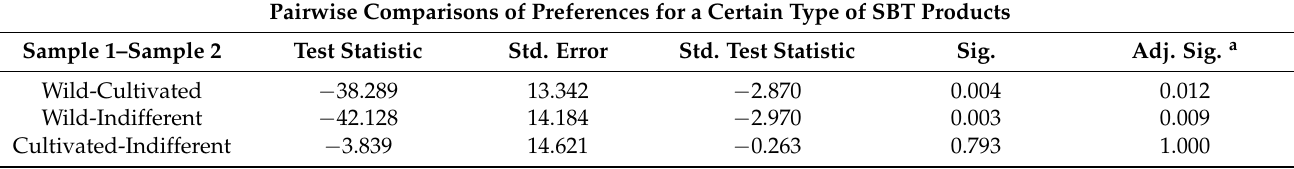
Table 5. Results of Kruskal Wallis test with the post-hoc test and Bonferroni correction for H3a. Pairwise Comparisons of Preferences for a Certain Type of SBT